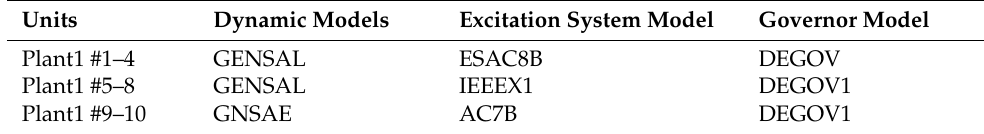
Table 6. Diesel Generator model in PSS ®